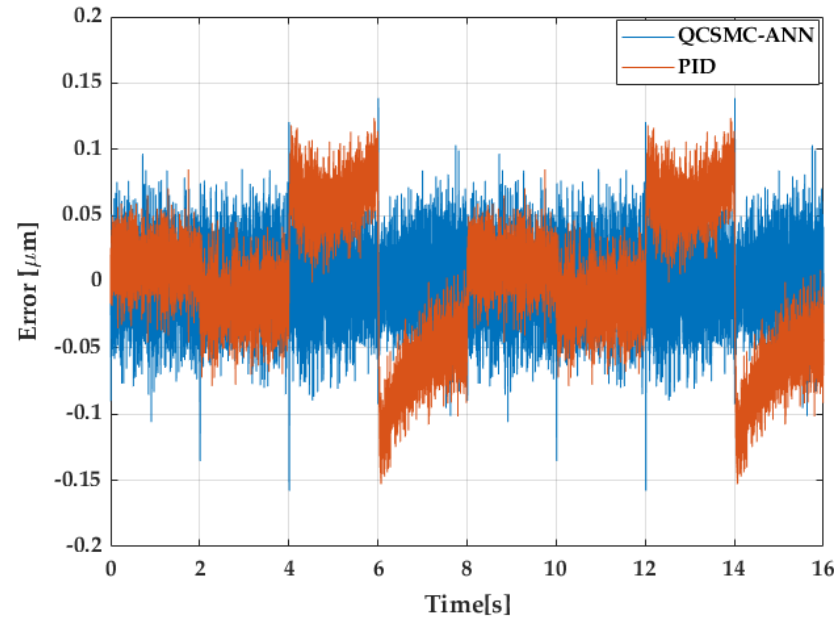
Figure 10. The error generated in 2 cycles of a triangular reference with variable amplitude.